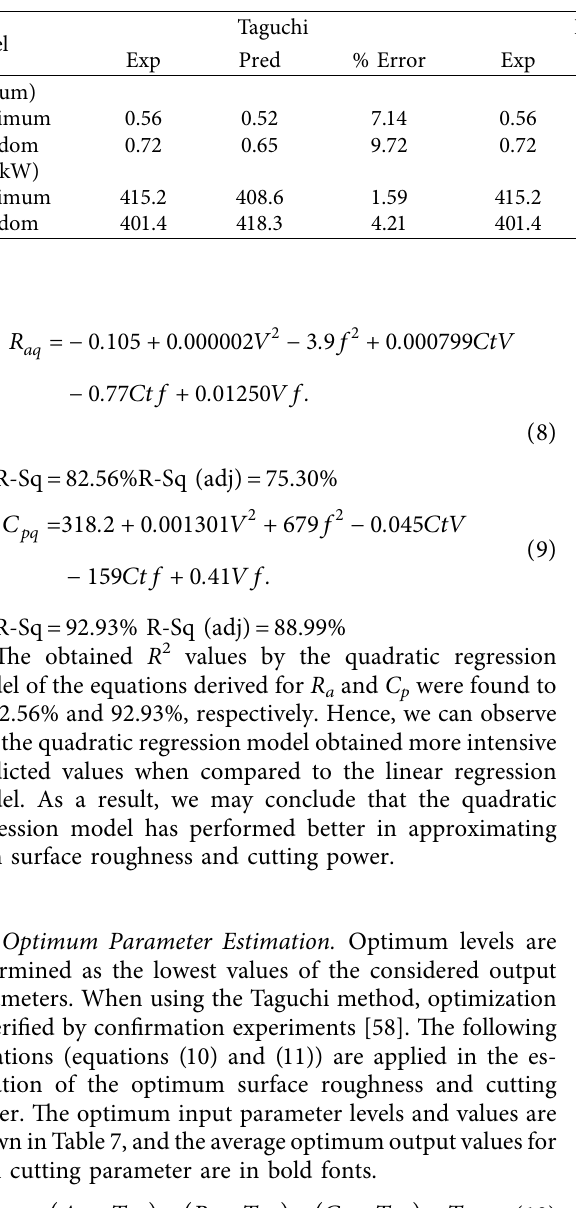
Table 8: Predicted values and confirmation test results by the Taguchi method and regression